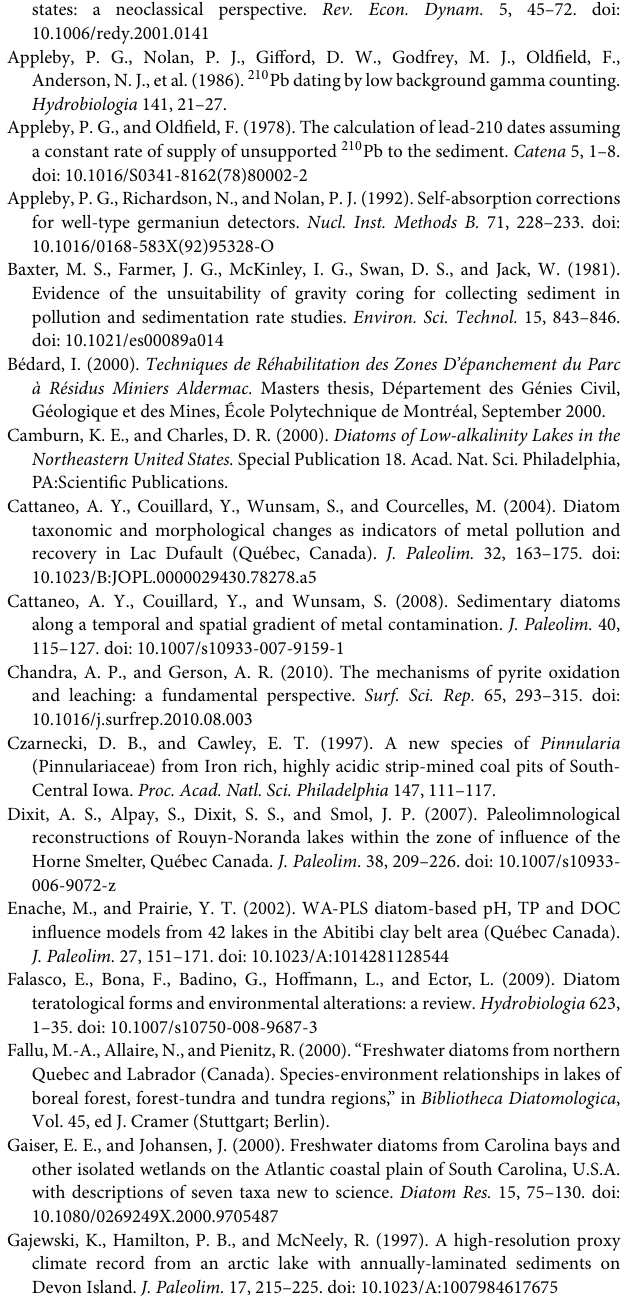
Figure S2 | 210 Pb ex as a function of depth (cm) in the sediments for each core. Data Sheet 1 | Diatom counts (relative abundances) for each of the four cores. Data Sheet 2 | Spectrum of pH optima estimates for the prominent taxa observed in this